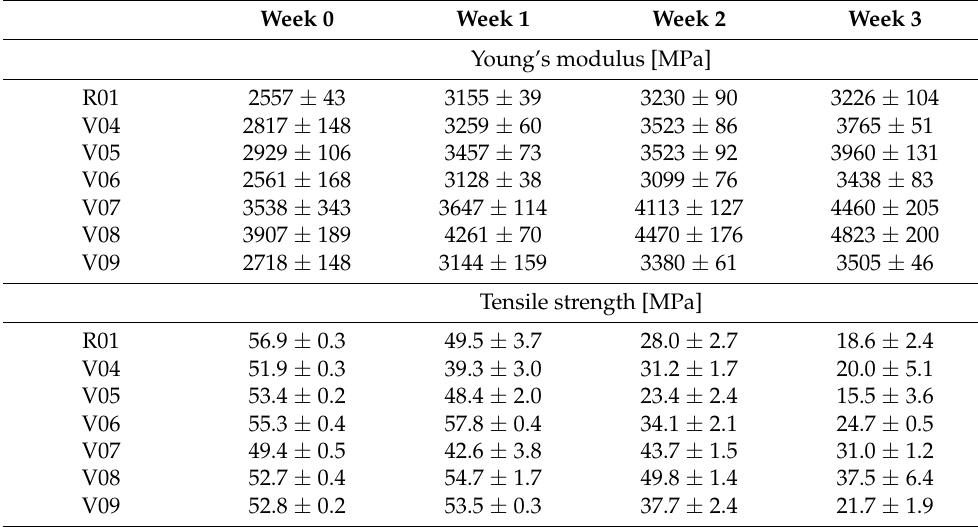
Table 4. Young’s modulus and tensile strength of tensile test specimen before and after 1, 2 and 3 weeks of composting.